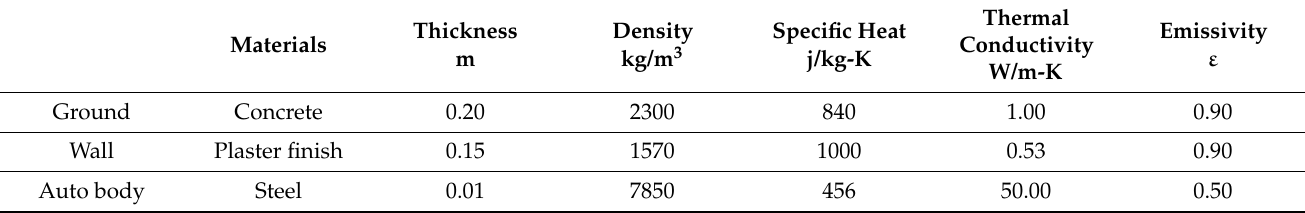
Table 2. Thermal properties of materials used (source: